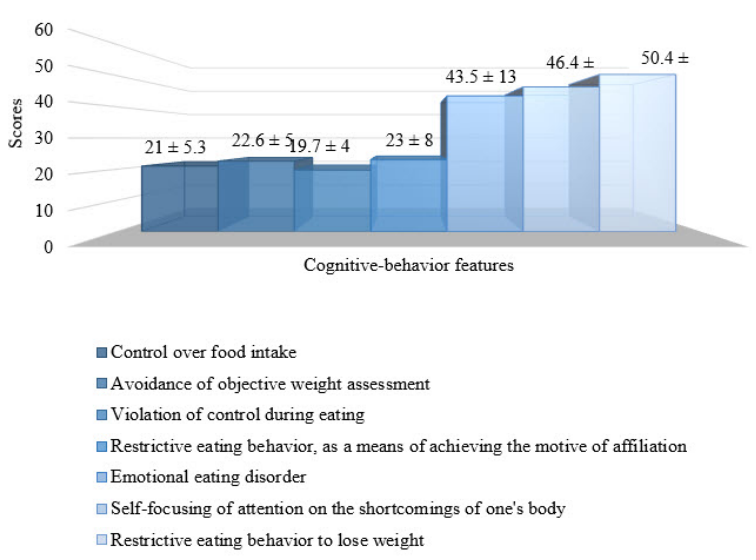
Figure 2. Mean values of the severity of cognitive features in persons with bulimia